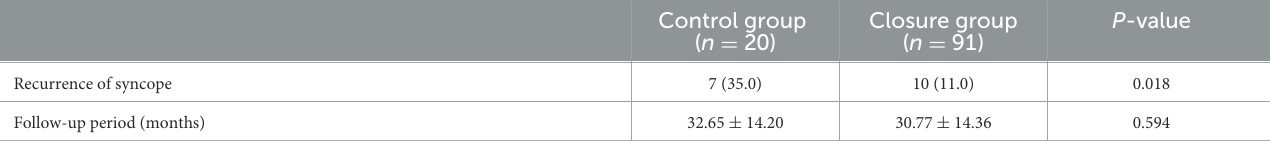
TABLE 2 Comparisons of syncope recurrence between the closure group and the control group.